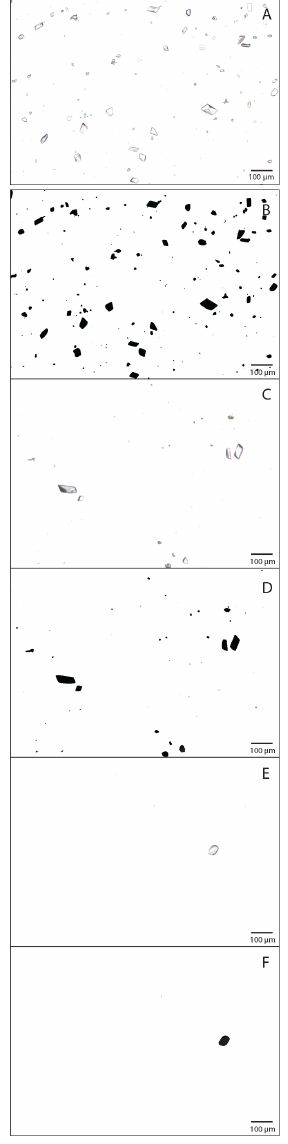
Figure 1. (A) Microscopic images of ikaite crystals a few seconds after melting 102mg sea ice (brine skim sample) from 22 January. Image represents a very small fraction (3µg) of the sample. (B) Software (ImageJ 1.45s) processing of image (A) to find the num- ber (159) and area (2.1% of counting area) of the crystals. (C) Mi- croscopic images of ikaite crystals a few seconds after melting 86 mg sea ice (from 2cm depth) from 22 January. Image represents a very small fraction (3µg) of the sample. (D) Software processing of image (C) to find the number (31) and area (0.4% of counting area) of the crystals. (E) Microscopic images of ikaite crystals a few sec- onds after melting 42mg sea ice (from 10cm depth) from 22 Jan- uary. Image represents a very small fraction (3µg) of the sample. (F) Software processing of image (E) to find the number (1) and area (0.05% of counting area) of the